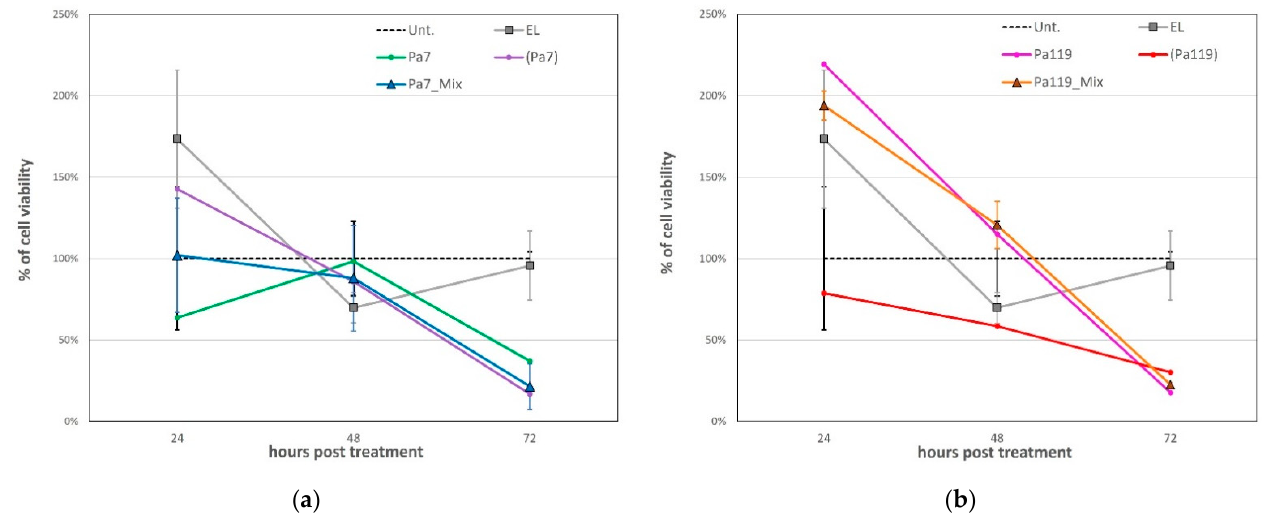
Figure 7. The bactericidal effect of the cocktail approach for lysins Pa7 ( a ) and Pa119 ( b ) and respective controls up to 72 h post-treatment. EL—empty liposomes; Pa7—Pa7 lysin in the free form; Pa119—Pa119 lysin in the free form; (Pa7)—Pa7 lysin encapsulated in liposomes; (Pa119)—Pa119 lysin encapsulated in liposomes; Pa7_Mix—lysin cocktail comprising free Pa7 lysin and Pa7 lysin encapsulated in liposomes; Pa119_Mix—lysin cocktail comprising free Pa119 lysin and Pa119 lysin encapsulated in liposomes; Unt.—untreated control. The untreated control is presented as a black dashed line for comparison. The combined application of free and encapsulated lysins did not increase their bactericidal effect.